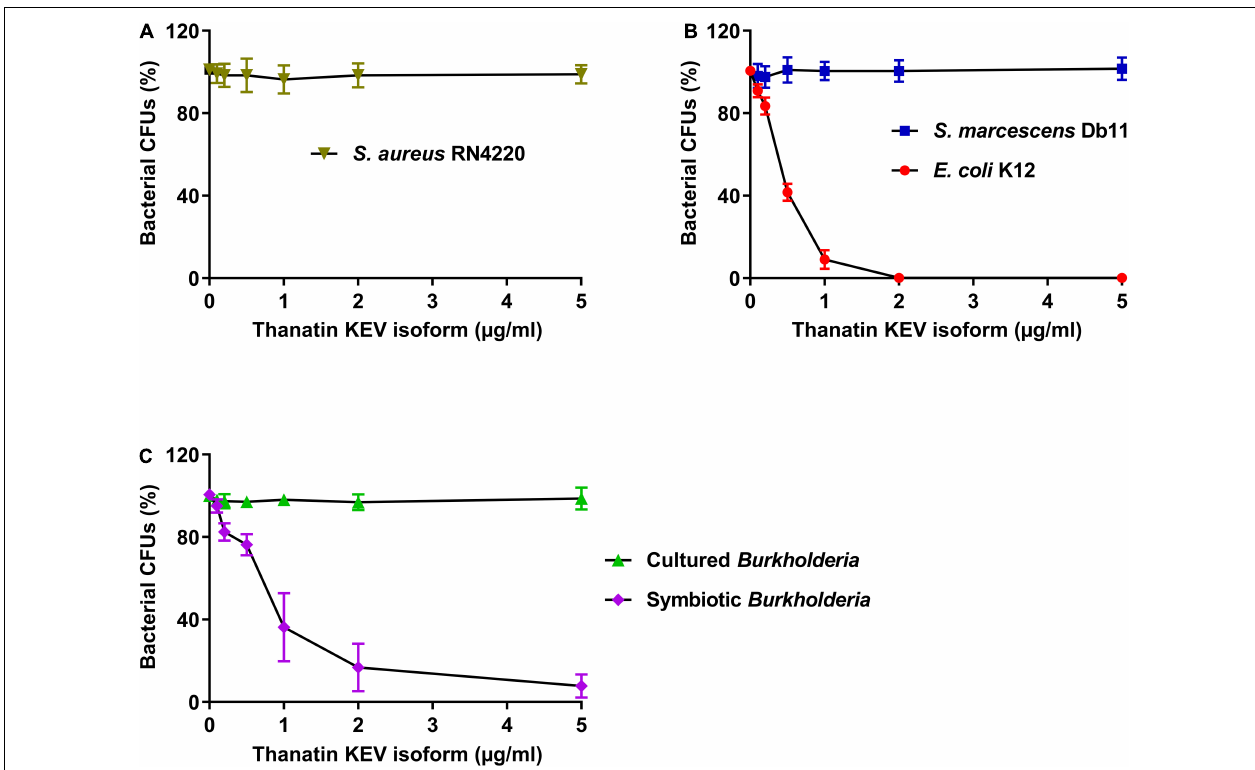
FIGURE 3 | Measurement of the antibacterial activity of thanatin isoforms. The antibacterial activity of thanatin isoforms against (A) S. aureus RN4220, (B) E. coli K12 and S. marcescens Db11, (C) cultured Burkholderia and symbiotic Burkholderia cells. The CFUs were calculated and normalized using AMP-untreated CFUs set to 100%. Data are expressed as mean ± SD ( n = 3) and are representative of three independent